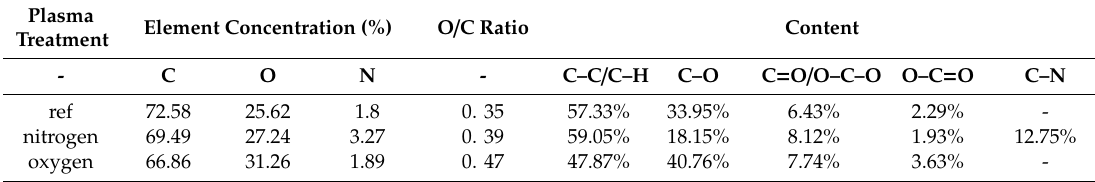
Table 1. Contribution of functional groups (%) on the surface of cherry